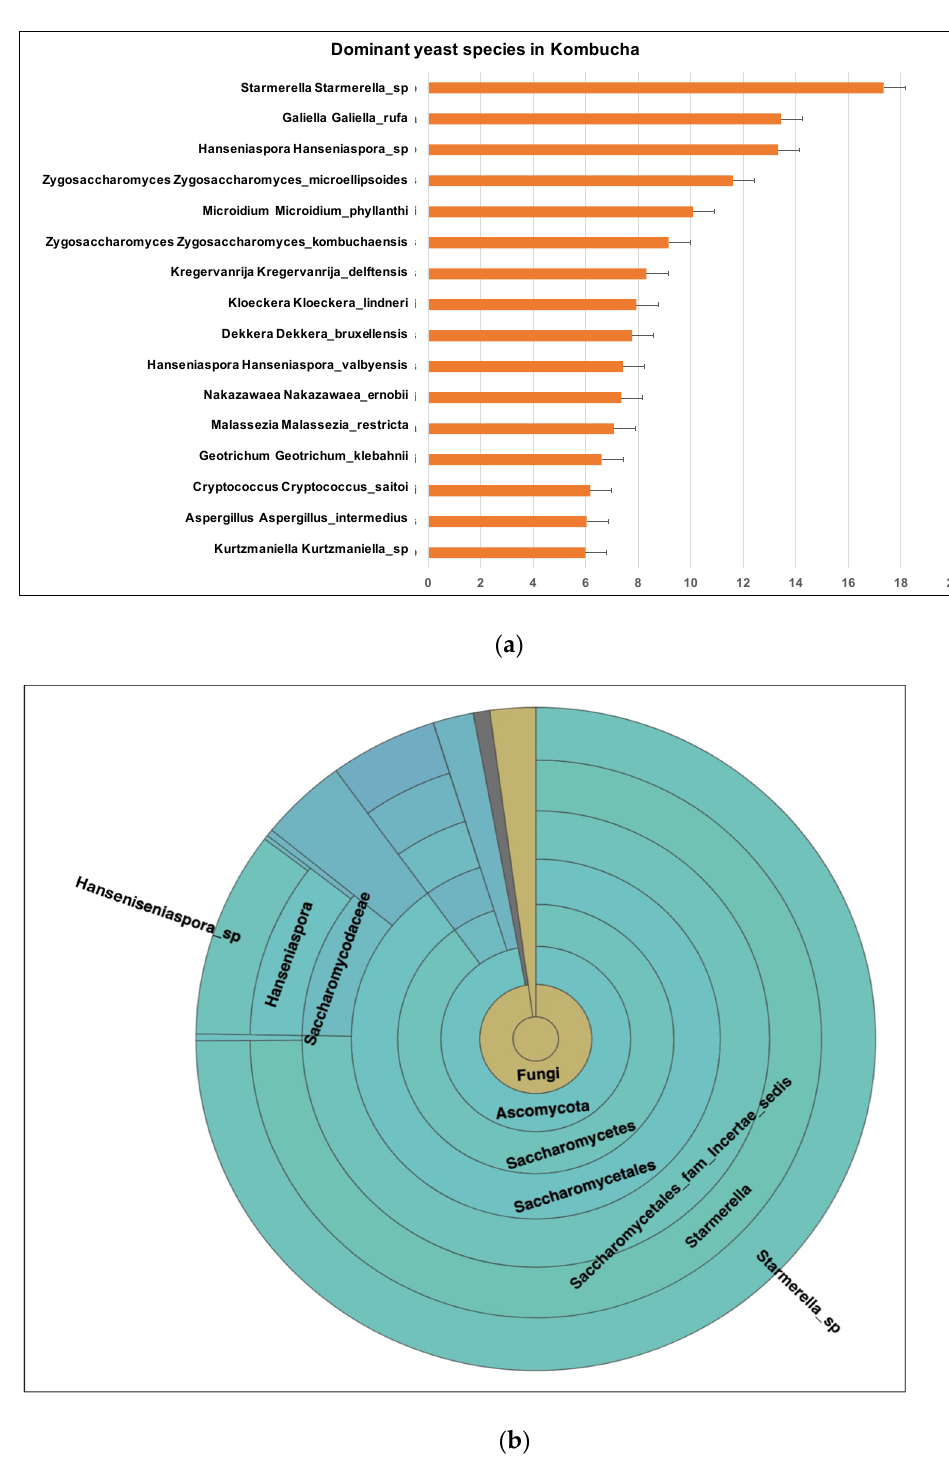
00.511.522.533.5